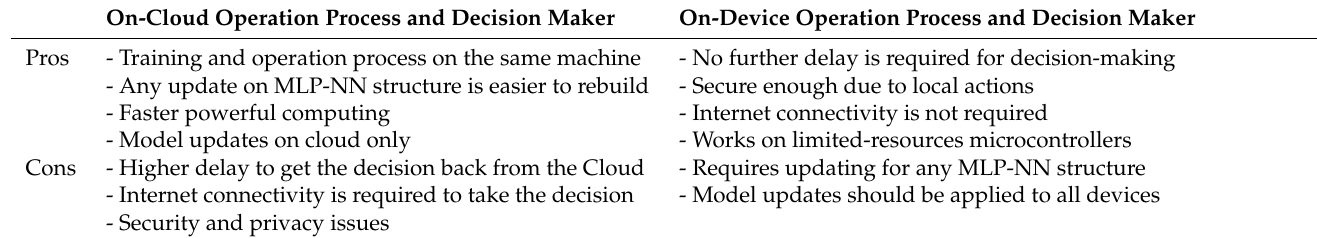
Table 5. The pros and cons of the On-Cloud operation process and decision maker, and the On-Device operation process and decision